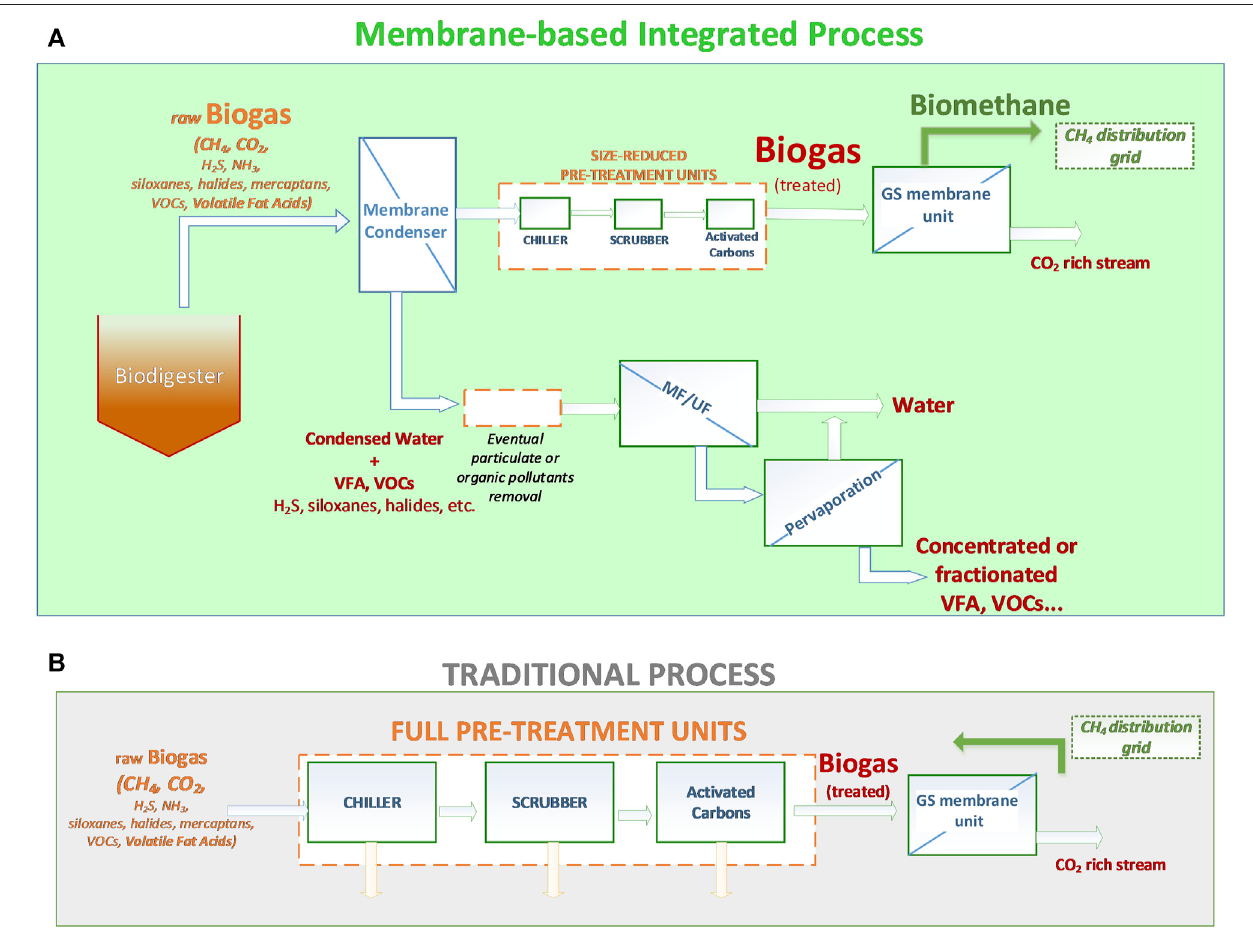
FIGURE 2 | Process schemes for biogas upgrading to biomethane, (A) integrated membrane process; (B) traditional process. Adapted from (https://www. meranet-biovalue.com).